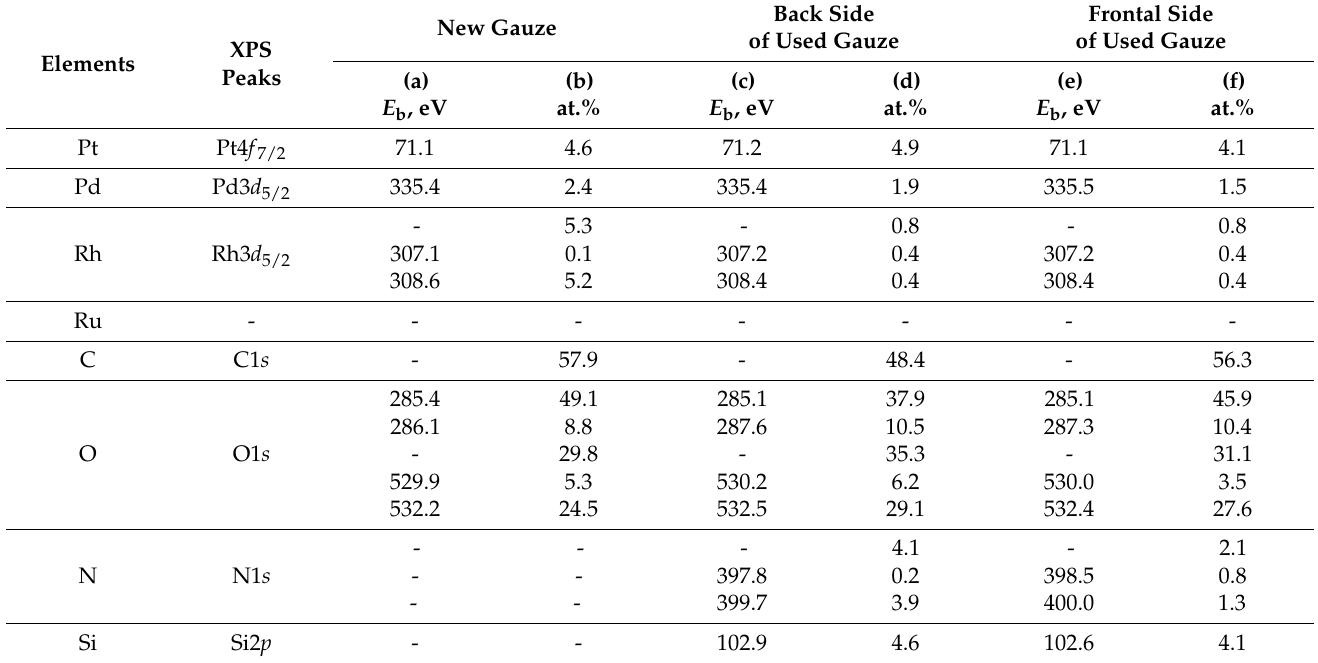
Table 1. Spectral characteristics and concentrations of the detected elements according to XPS data, particularly those calculated from the peaks obtained by deconvolution of Rh3 d 5/2 , O1 s , N1 s and C1 s spectra (Figure 4) for the fresh Pt–Pd–Rh–Ru gauze (a,b) and for the back (c,d) and frontal (e,f) sides of the gauze used in NH 3